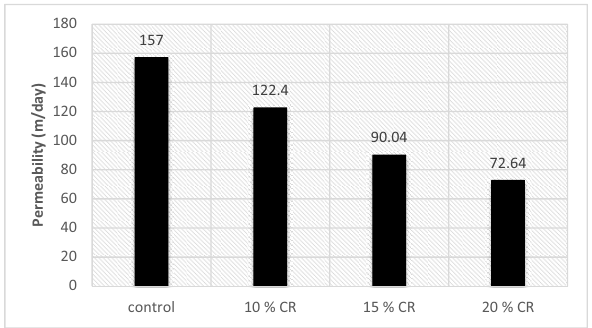
Figure 11: Permeability test